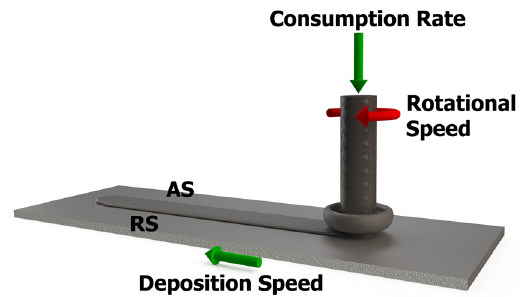
Figure 1. Schematic presentation of FS process 6